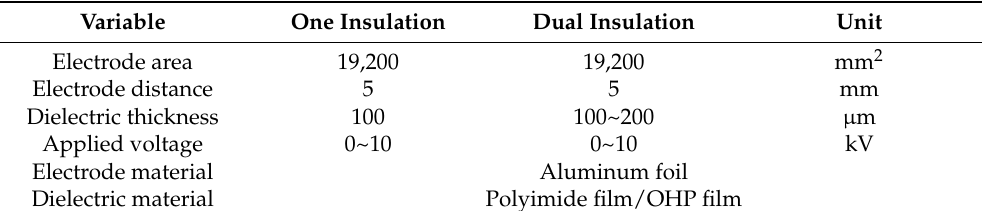
Table 1. Specifications of the electroadhesion pad for an adsorption experiment.